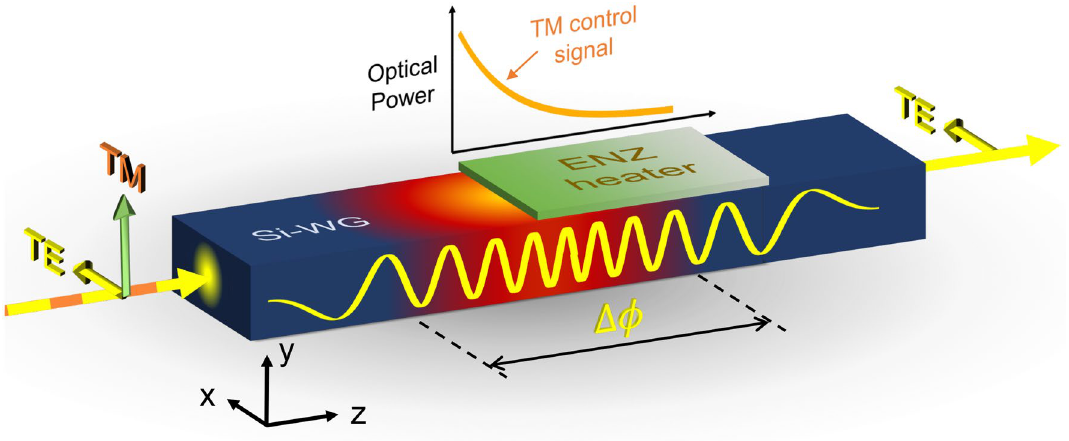
Figure 1. Illustration of the proposed all-optical phase shifter. The optical heater is an ENZ material that heats up due to the absorbed optical power of the TM polarized mode. The phase shift is induced for TE polarization by exploiting the silicon thermo-optic coefficient and leads to low optical loss due to the pass polarizer operation of the hybrid waveguide